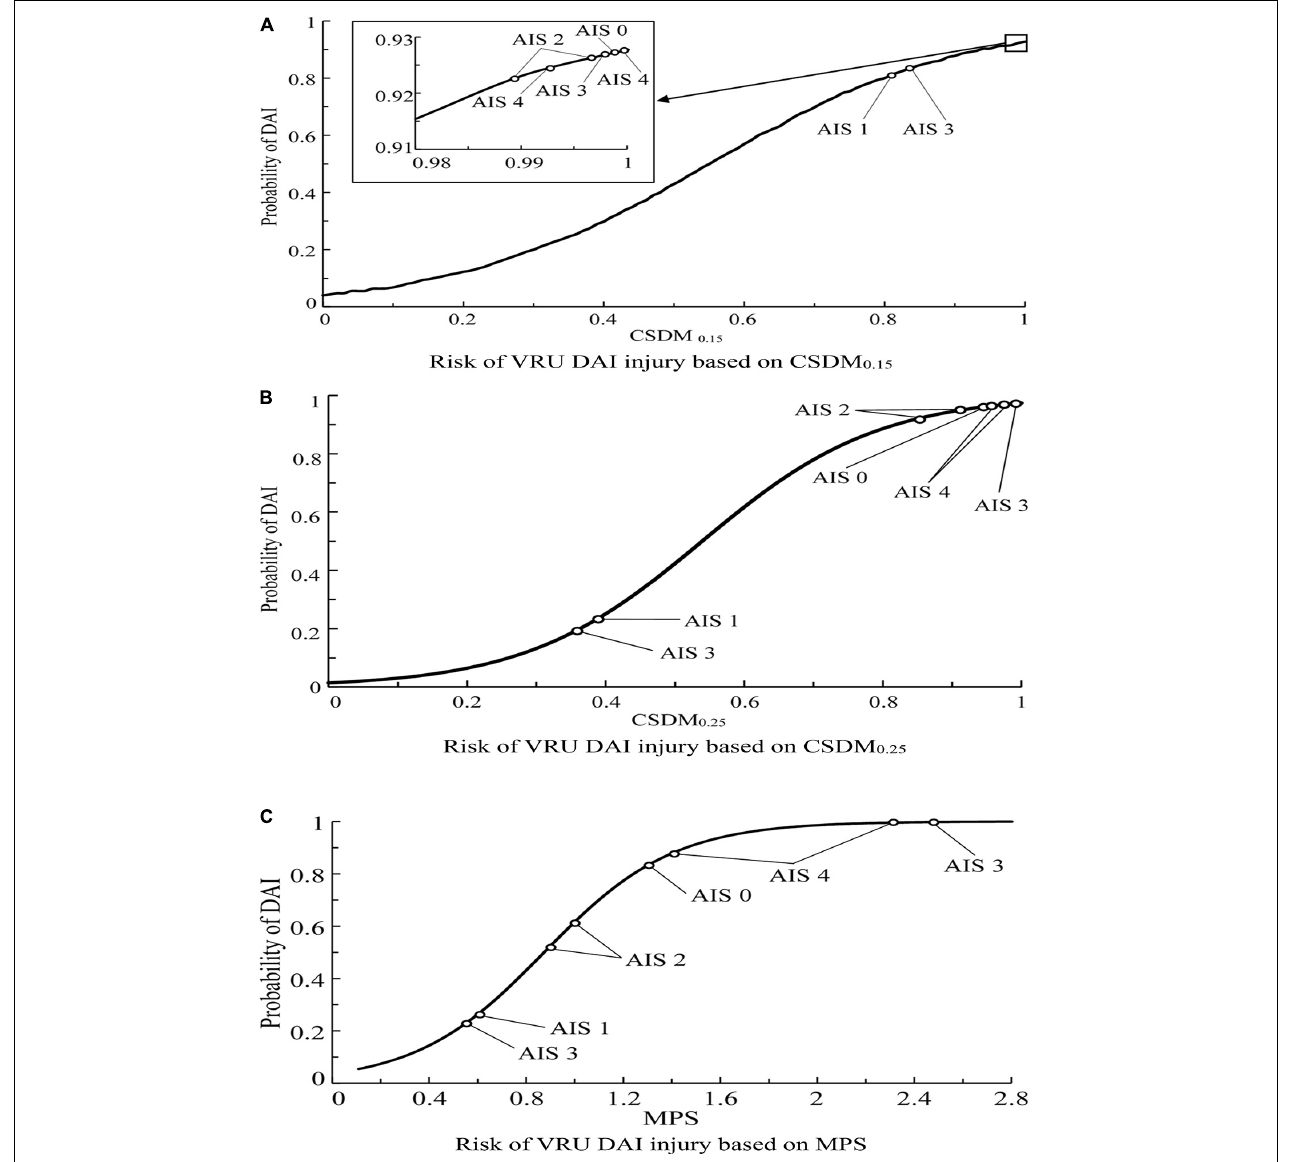
FIGURE 11 | Predicted probability of the DAI occurrence for the VRU impact accident cases analyzed in this study using brain injury risk curves reported in the literature (Takhounts et al., 2003, 2008). (A) Risk of VRU DAI injury based on CSDM 0 . 15 , (B) Risk of VRU DAI injury based on CSDM 0 . 25 , and (C) Risk of VRU DAI injury based on MPS. DAI, diffuse axonal injury; VRU, vulnerable road user; MPS, maximum principal